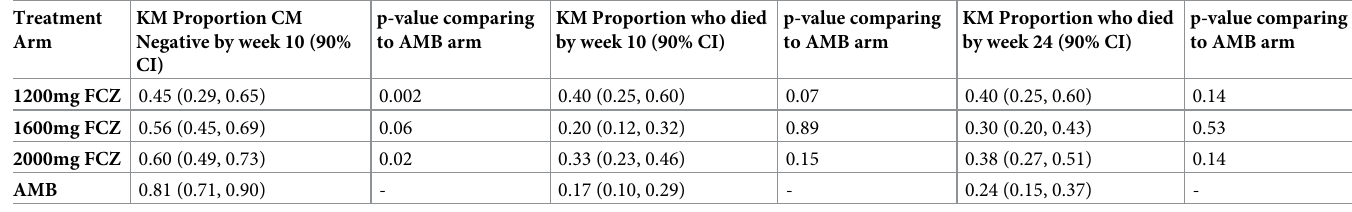
Table 5. Pairwise comparisons of FCZ with AMB.